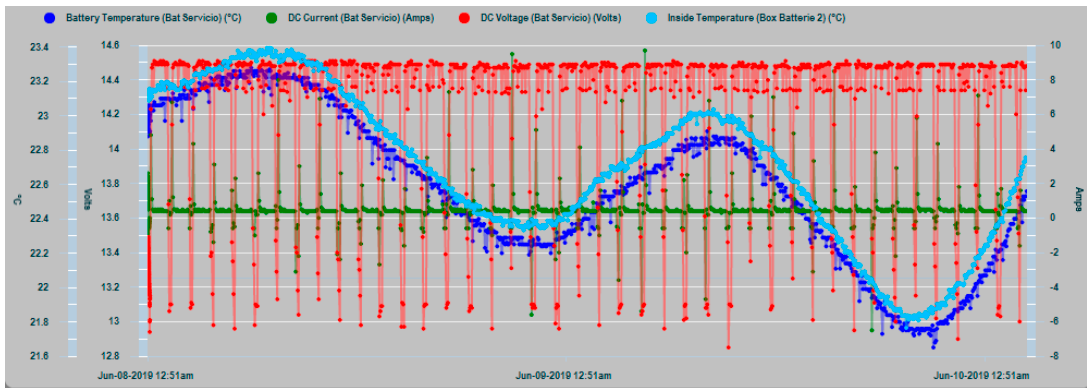
Figure 24. Ambient T amb (clear blue), battery temperature T in (dark blue), voltage V float (red), and current I float (green) over 48 h.